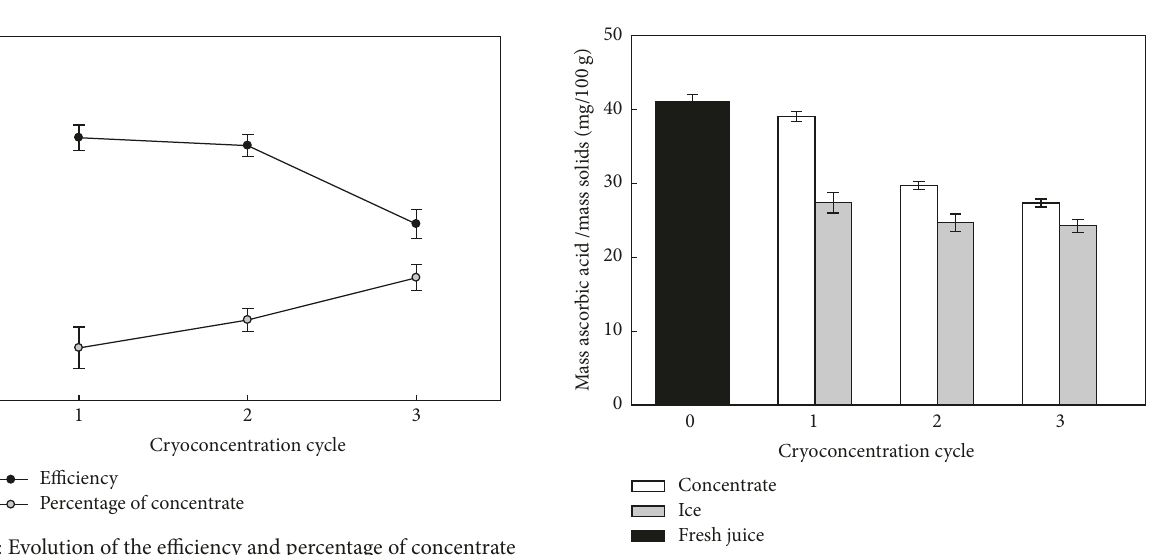
the concentrated and ice fraction as a function of the cryoconcen- tration